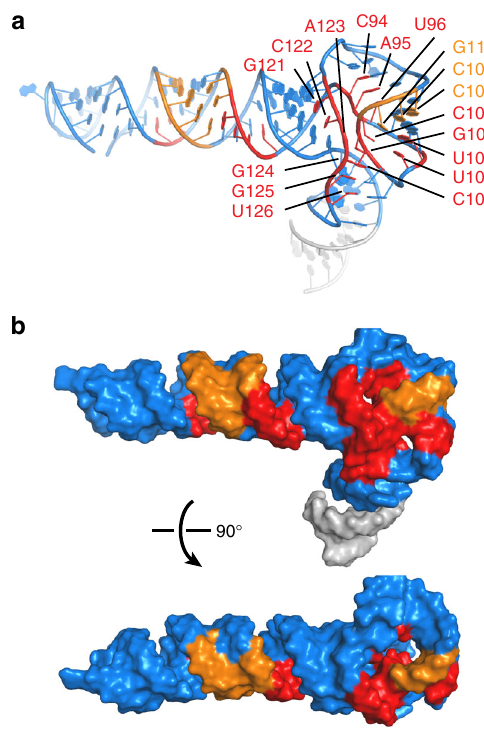
Fig. 5 PKR footprint on VA-I. a Cartoon illustration of VA-I residues protected by PKR binding from RNase digestion (red) and chemical probes (orange) 61 . Nucleotides 86 – 89 are protected from both. b Surface representations of ( a ) show two contiguous binding surfaces located in the apical stem and central domain on the same face of